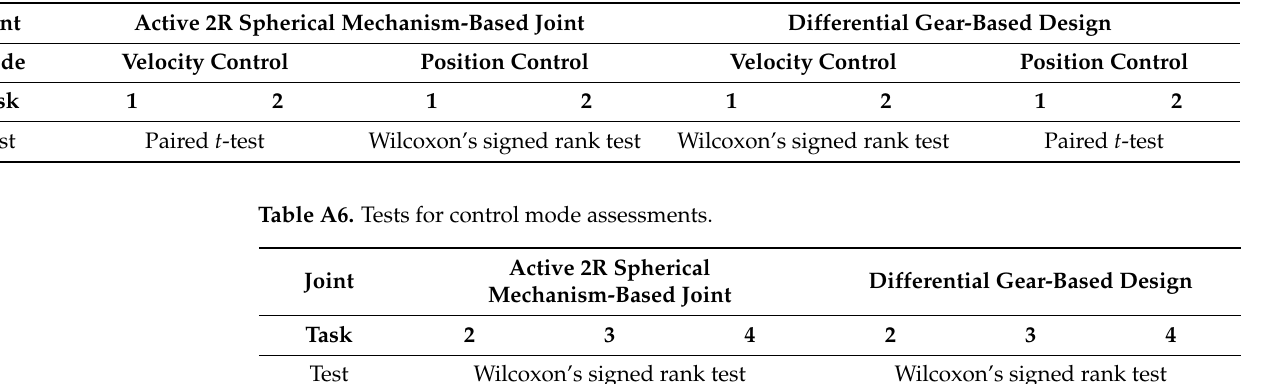
Table A5. Statistic tests for the evaluation of force feedback systems.